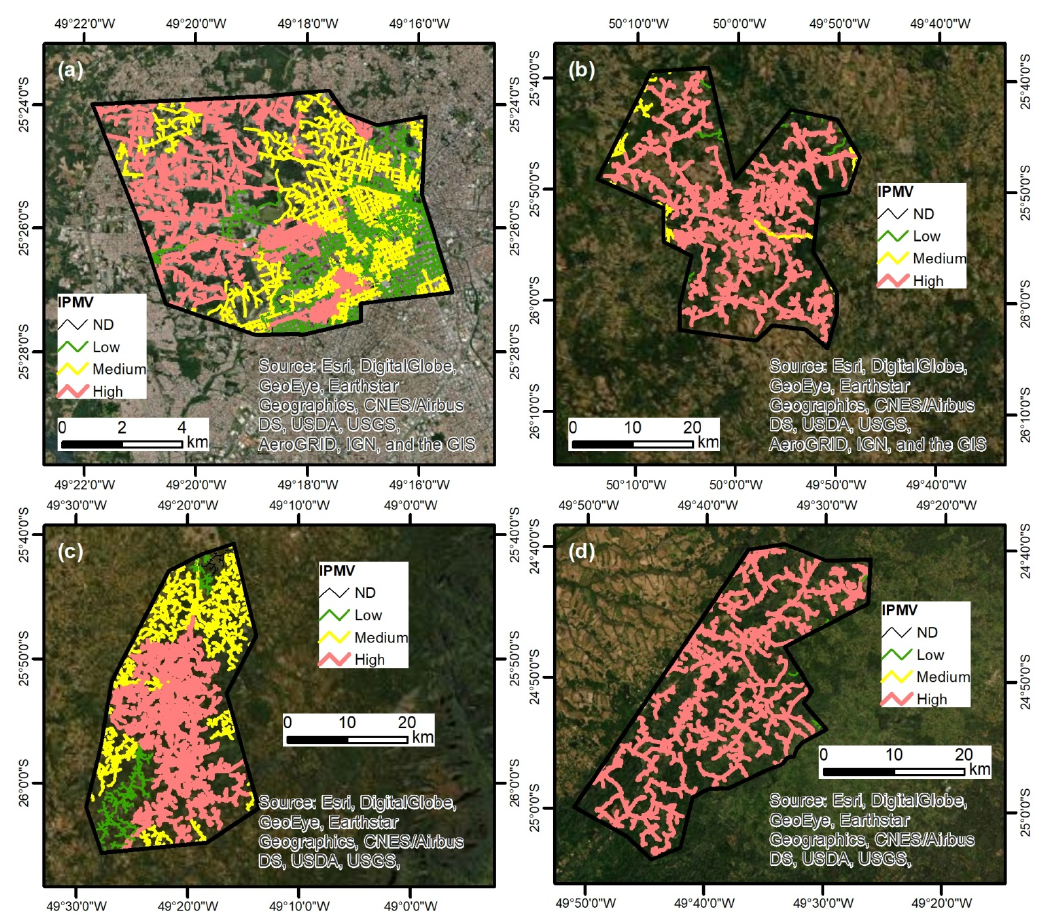
Figure 7. Spatial distribution of PIVM: ( a ) S1; ( b ) S2); ( c ) S3; and ( d ) S4.